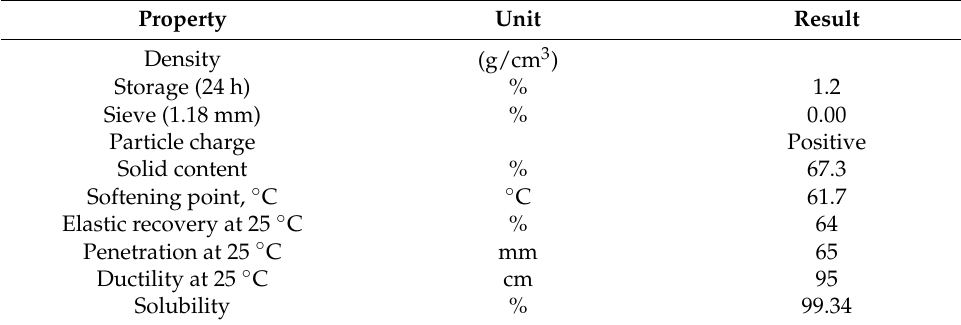
Table 2. Properties of the CAE.